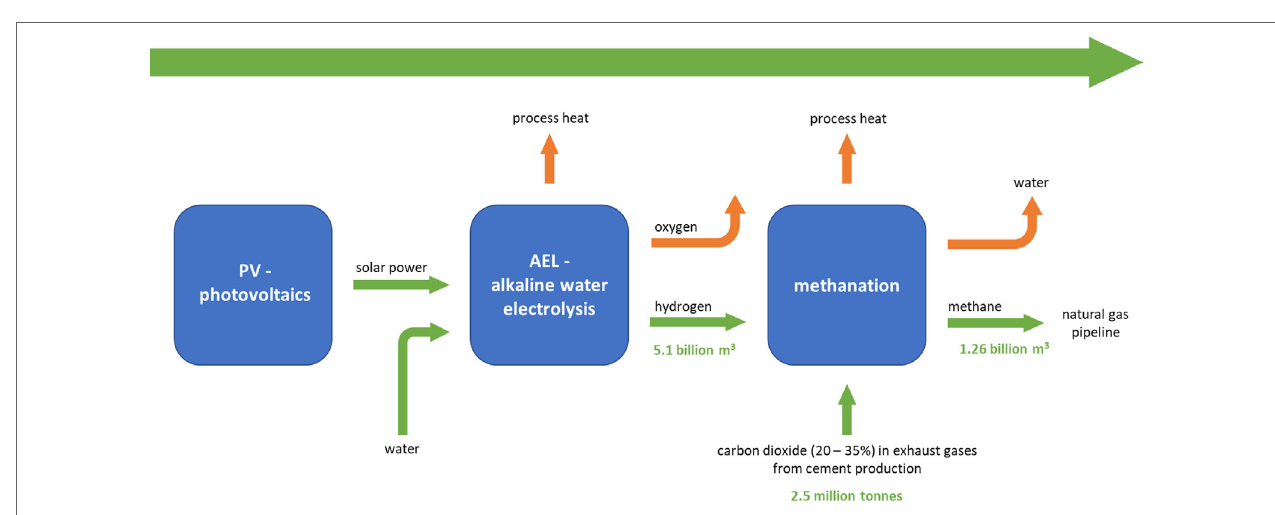
FigUre 3 | Illustration of the power-to-gas process for cement based CO 2 emissions (Fischedick, 2015).